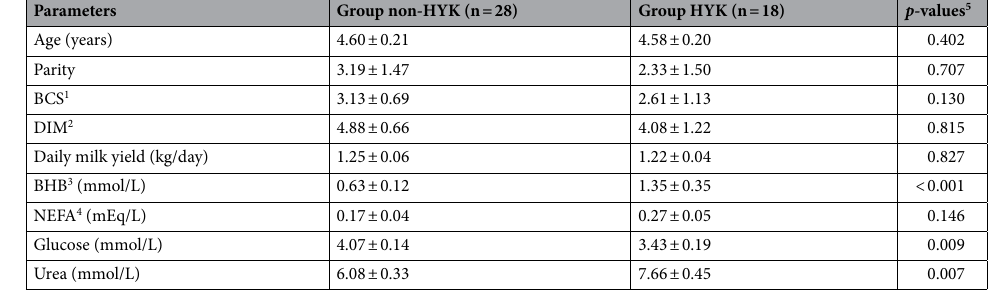
Table 1. Mean values ± standard of the mean (SEM) of clinical data and biochemical parameters of dairy ewes divided in group Non-HYK (BHB < 0.80 mmol/L) and group HYK (BHB ≥ 0.80 mmol/L). 1 Body condition score. 2 Days in milk. 3 β-Hydroxybutyrate. 4 Nonesterified fatty acids. 5 P -values corrected with Bonferroni